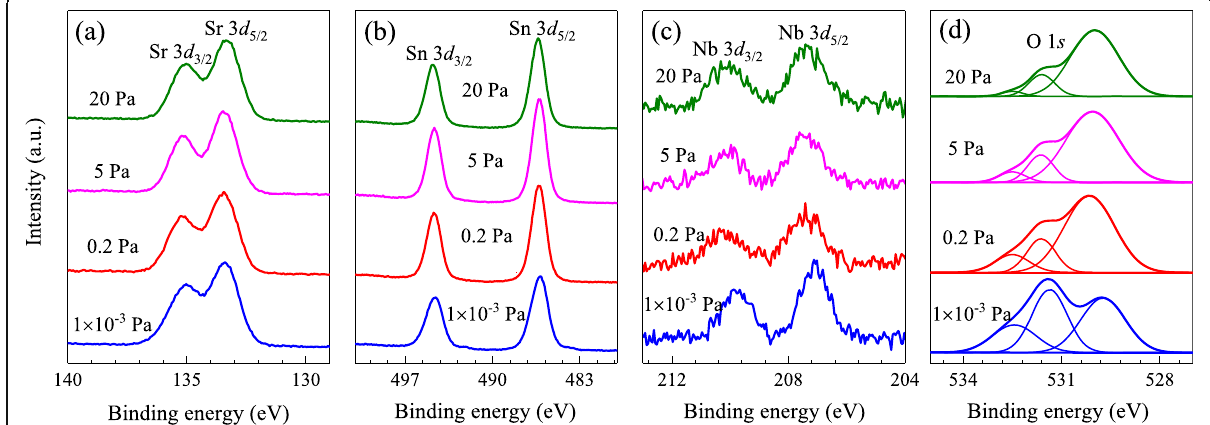
Fig. 3 XPS spectra of ( a ) Sr 3 d , ( b ) Sn 3 d , ( c ) Nb 3 d , and ( d ) O 1 s obtained from the SSNO films with various oxygen